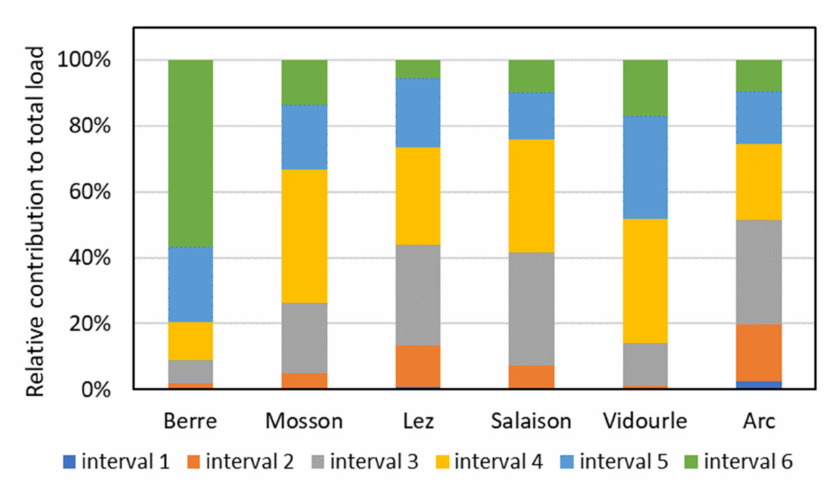
Figure 11. Relative contribution of each flow interval to the mean annual load of total nitrogen.